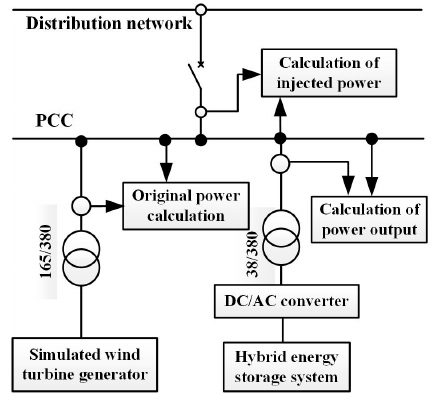
Figure 14. The structure of the joint testing system.